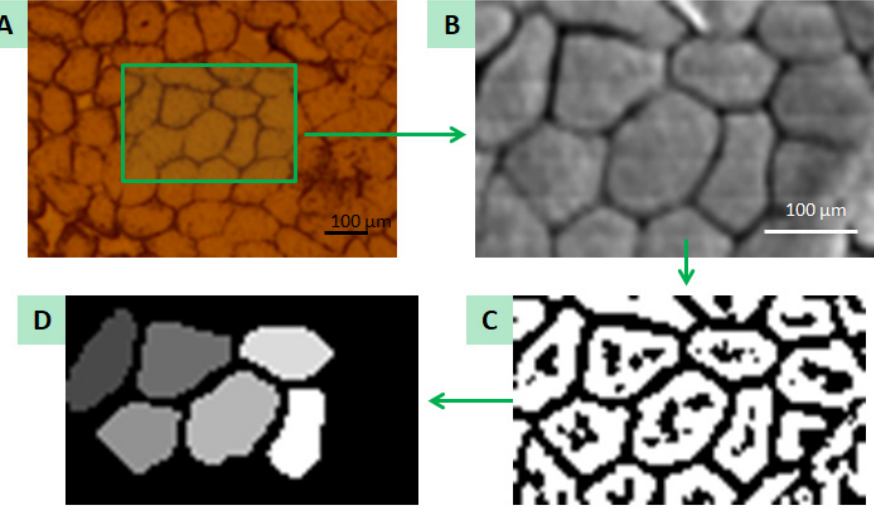
Figure 8. Graphical representation of steps needed to obtain the mask from an ROI image by binarisation: ( A ) a photo of the sample taken with an optical microscope with the marked area of measurement; ( B ) ROI image; ( C ) ROI image binarisation; ( D ) created mask.